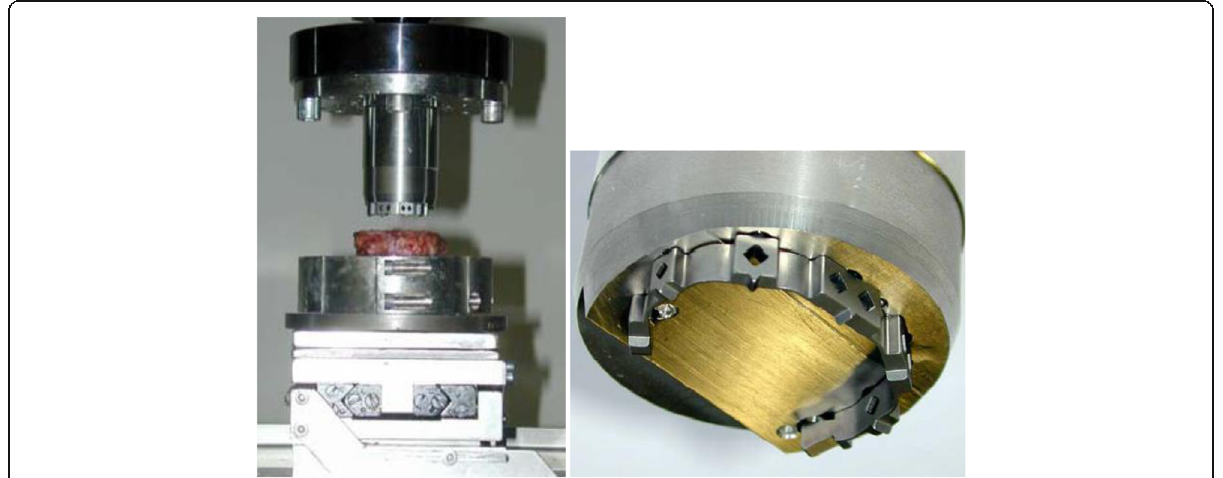
Fig. 3 Setup for the axial compression test of the MAC cage designs